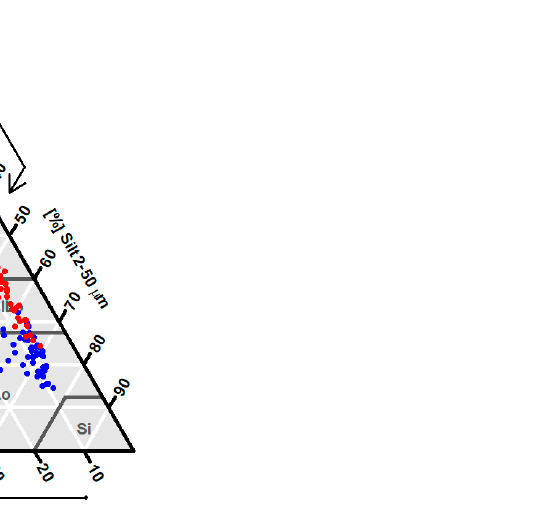
Figure 2. Soil texture classes in SA (red circles) and K (blue circles) regions based on the WRB classification system.